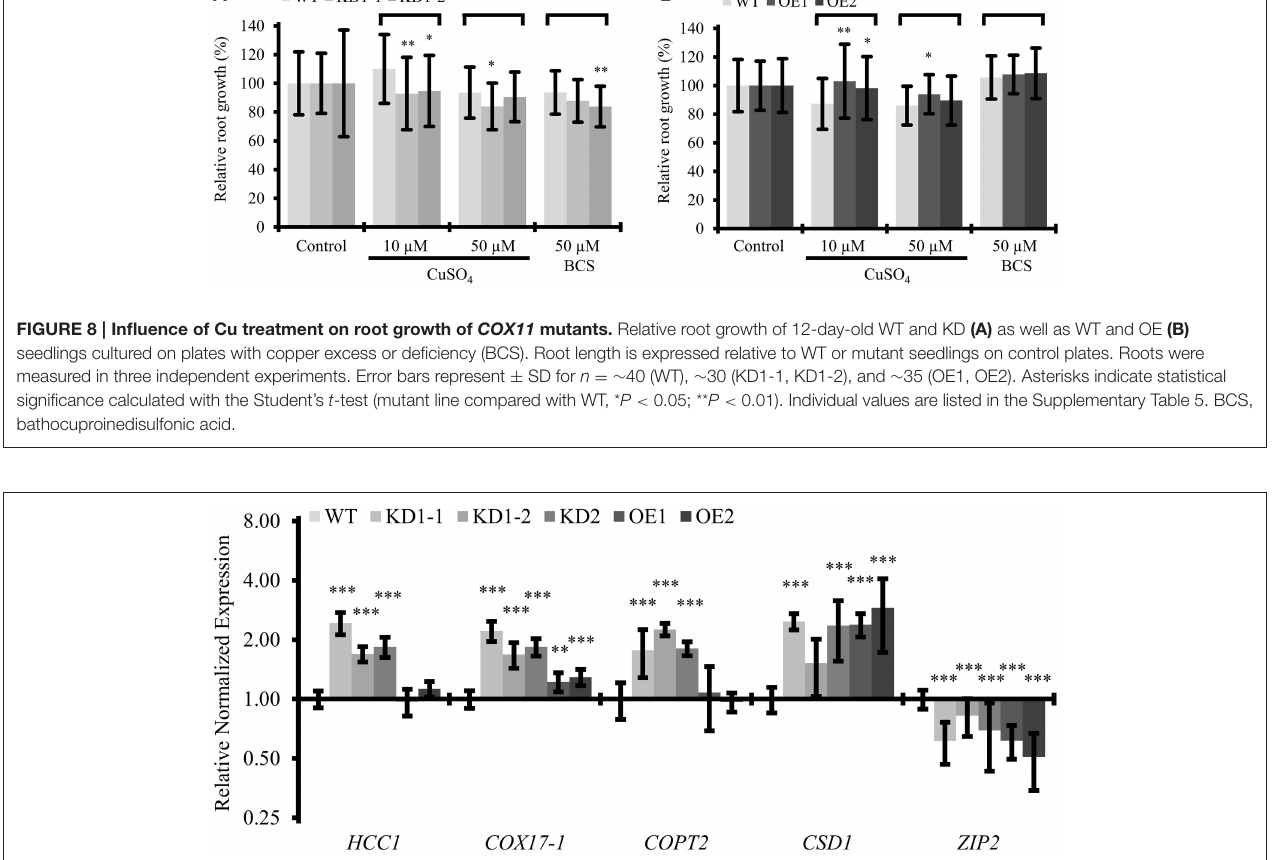
FIGURE 9 | Quantitative analysis of transcripts associated with copper metabolism. qPCR analysis of indicated transcripts in WT and COX11 mutants. RNA was isolated from 14-day-old seedlings cultured on selective (KD) or non-selective MS (WT, OE) plates. Mean values of mRNA levels in COX11 mutants were normalized to WT and plotted on a logarithmic scale (base two). Values and statistical significance (compared with the WT, ** P < 0.01 ; *** P < 0.001 ) were calculated with the CFX manager software. Error bars represent ± SD. Individual values are listed in the Supplementary Table